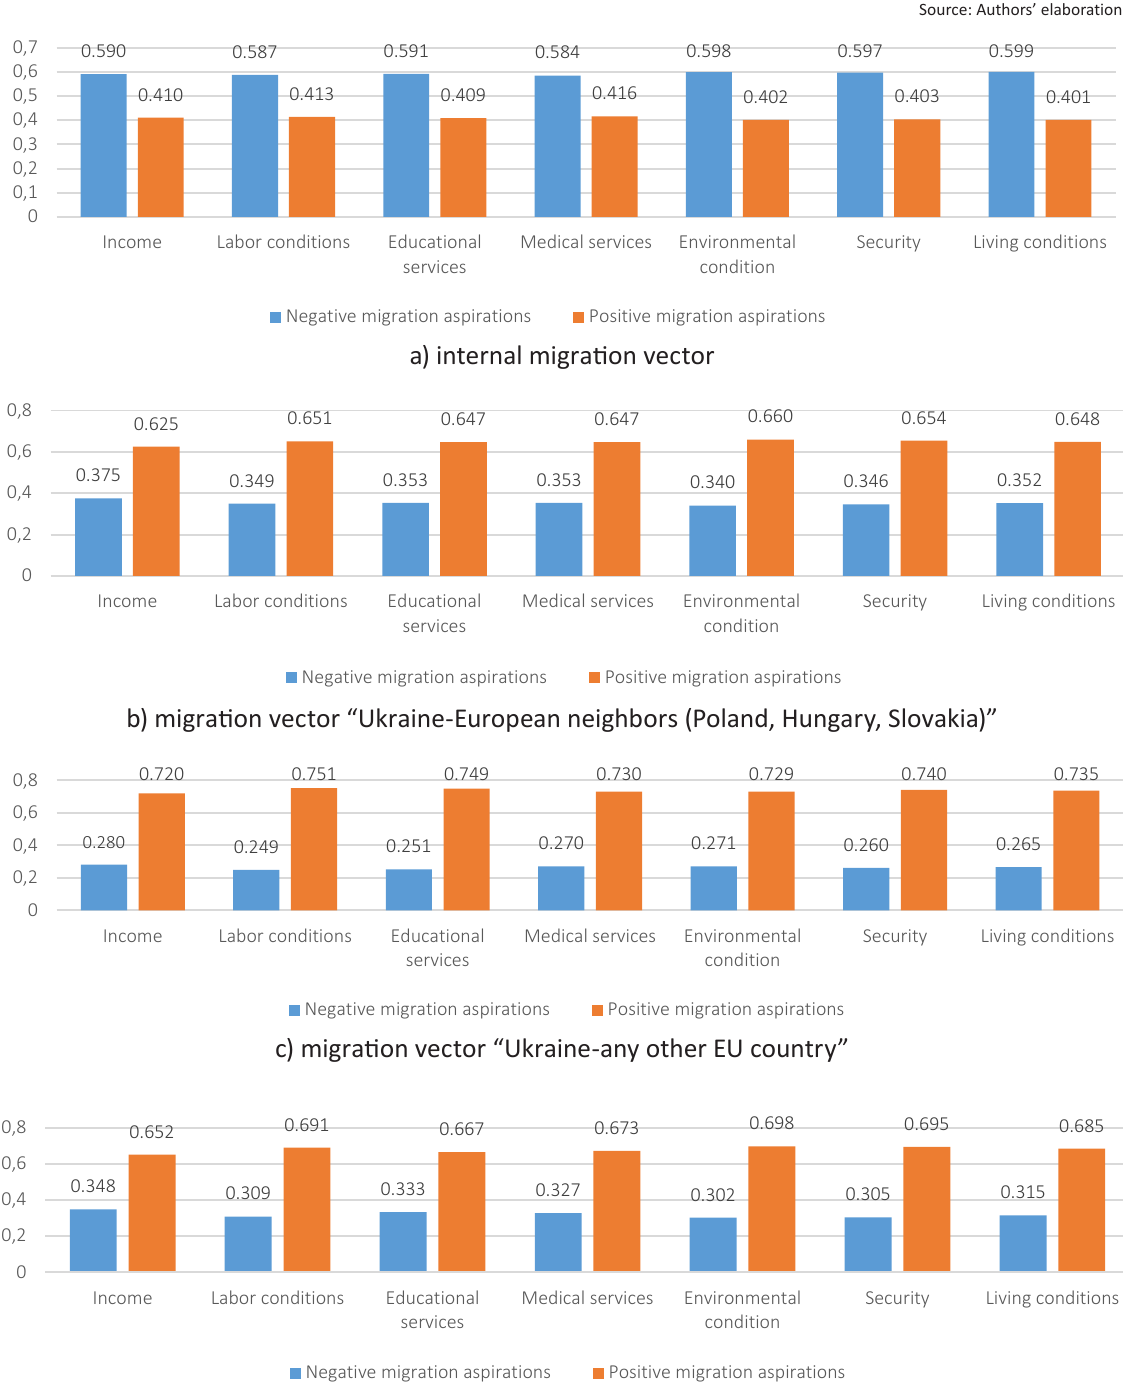
Figure 2. Levels of migration aspirations in the focus of deprivation components, Lviv Oblast,